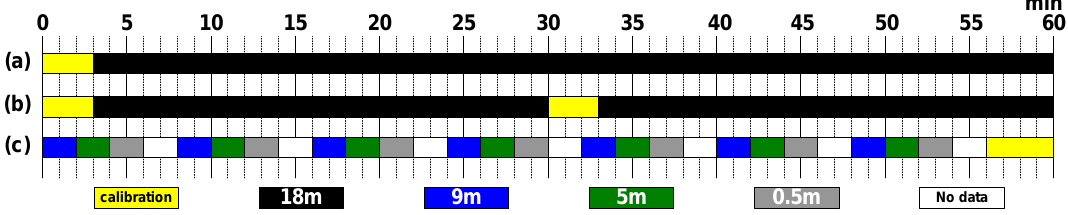
(b: TD-LIF) and 3 2